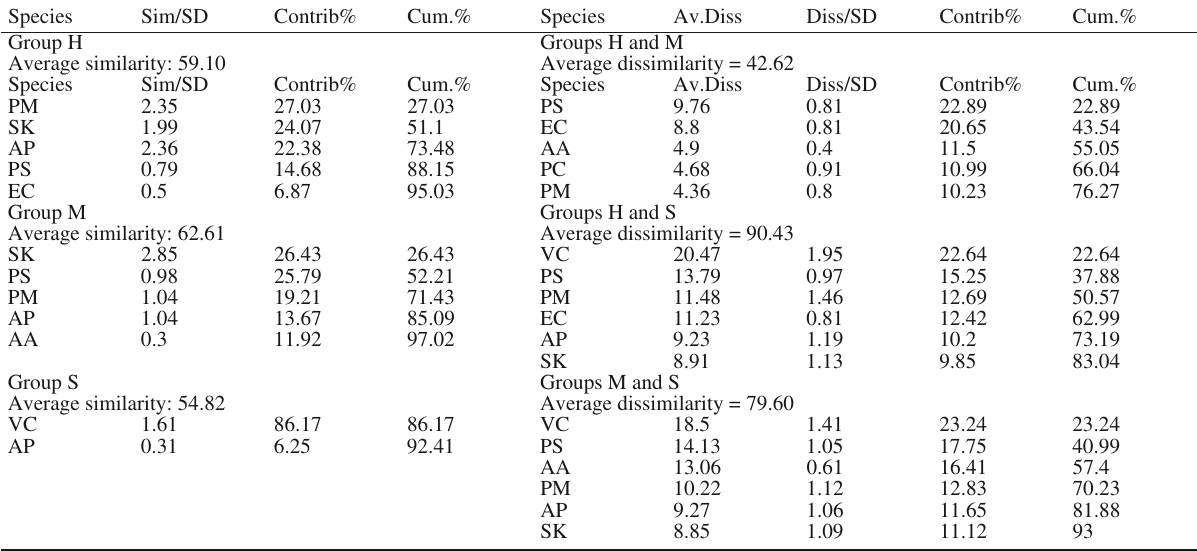
Table 4. – Results of the SIMPER analyses showing similarities within substrate groups; dissimilarities between pairs of substrate groups and the species mostly responsible for the observed differences. PM, Paramuricea macrospina ; PC, Paramuricea clavata ; SK, Spinimuri- cea klavereni ; EC, Eunicella cavolini ; AP, Alcyonium palmatum ; AA, Alcyoium acaule ; PS, Paralcyonium spinulosum ; VC, Veretillum cynomorium. Species Sim/SD Contrib% Cum.% Species Cum.% Group H Groups H and M Average similarity: 59.10 Average dissimilarity = 42.62